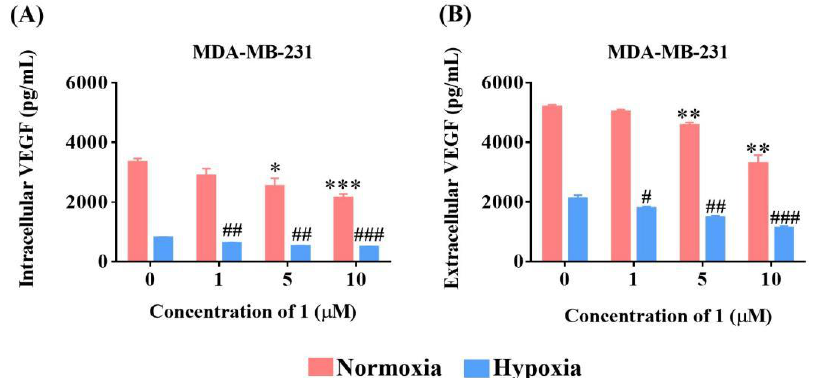
Figure 4. The effect of 1 on intracellular and extracellular VEGF expression in MDA-MB-231 cells. The inhibition of intracellular ( A ) and extracellular ( B ) VEGF expression level under hypoxia and normoxia were determined using human VEGF ELISA kit. ( n = 3, means ± SEM are shown; * p < 0.05, ** p < 0.01, *** p < 0.001, compared with control under normoxia; # p < 0.05, ## p < 0.01, ### p < 0.001, compared with control under hypoxia).